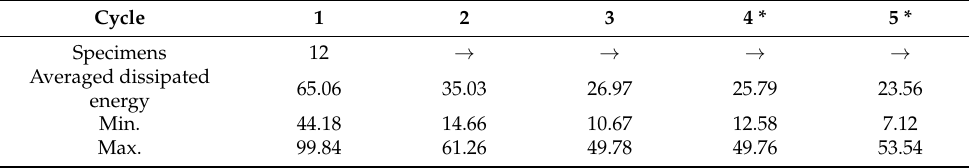
Table A1. Average energy dissipation per cycle (five cycles of 785 kN) (unit = kN · mm).